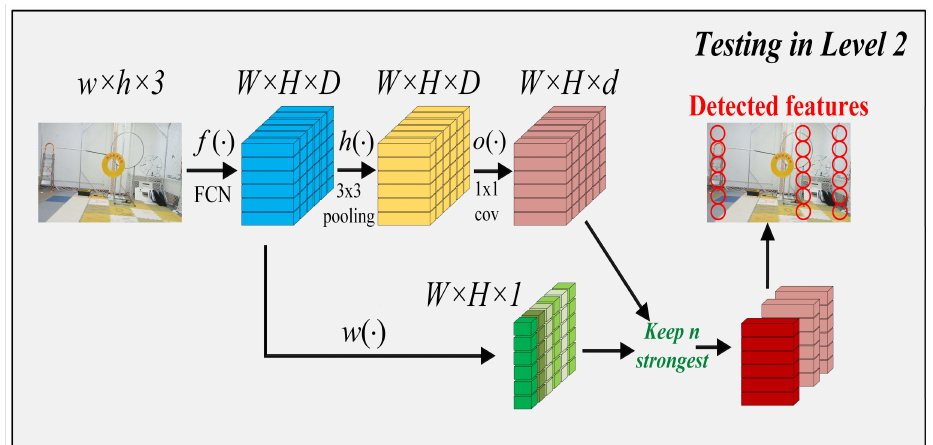
Figure 2. Testing architecture